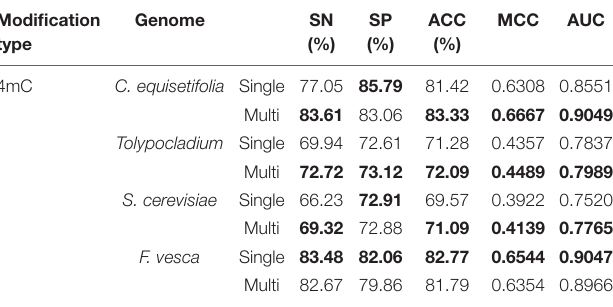
TABLE 2 | Comparison results of the model using the multi-task learning and the model not using the multi-task learning for identifying 4mC site.